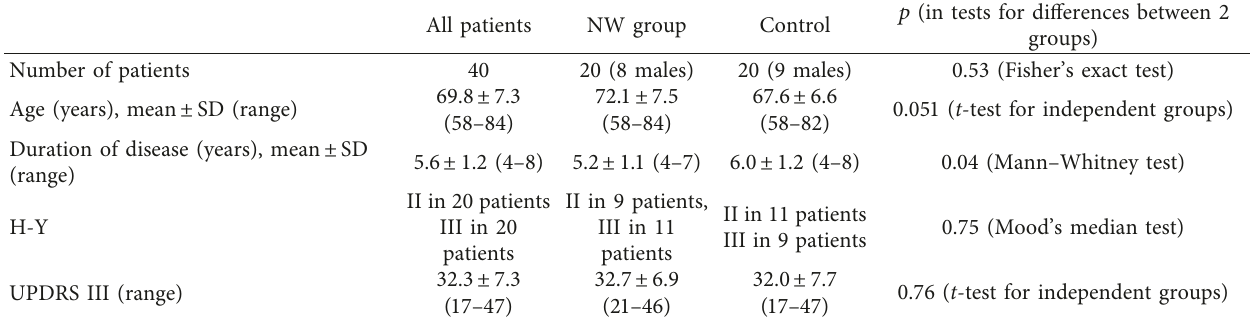
Table 1: Baseline patients’